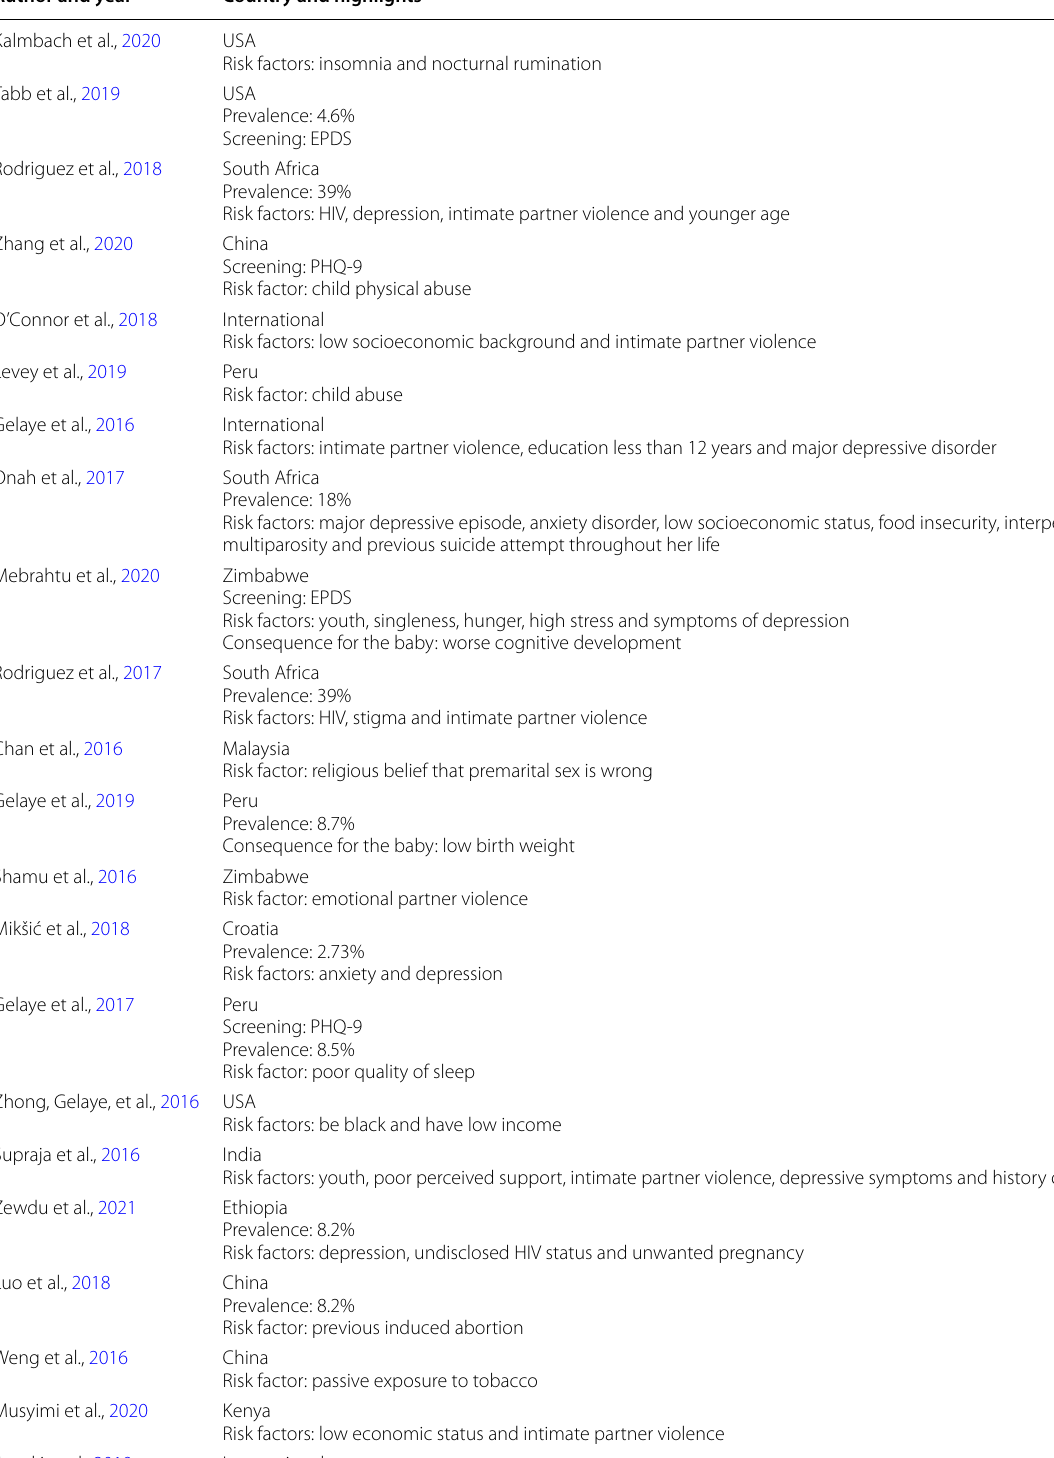
Table 4 Summary of reviewed studies on suicidal ideation during